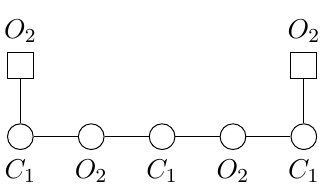
Figure 72. Quiver obtained from brane system in the fourth row of table 6. Its Higgs branch is M H = A [ A 5 5